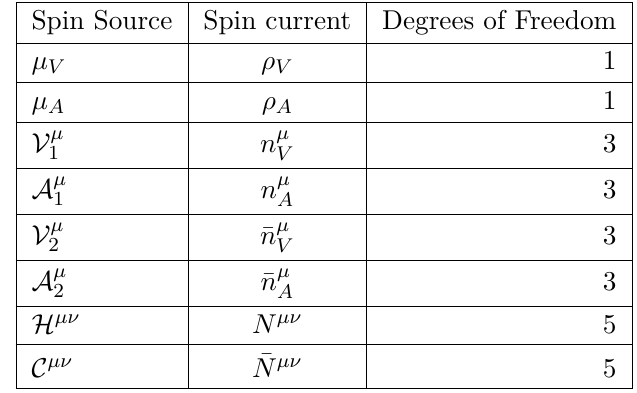
Table 1 . Hydrodynamic decomposition of the spin sources and the spin current. Each source is paired with the component of the spin current it sources together with their corresponding number of degrees of